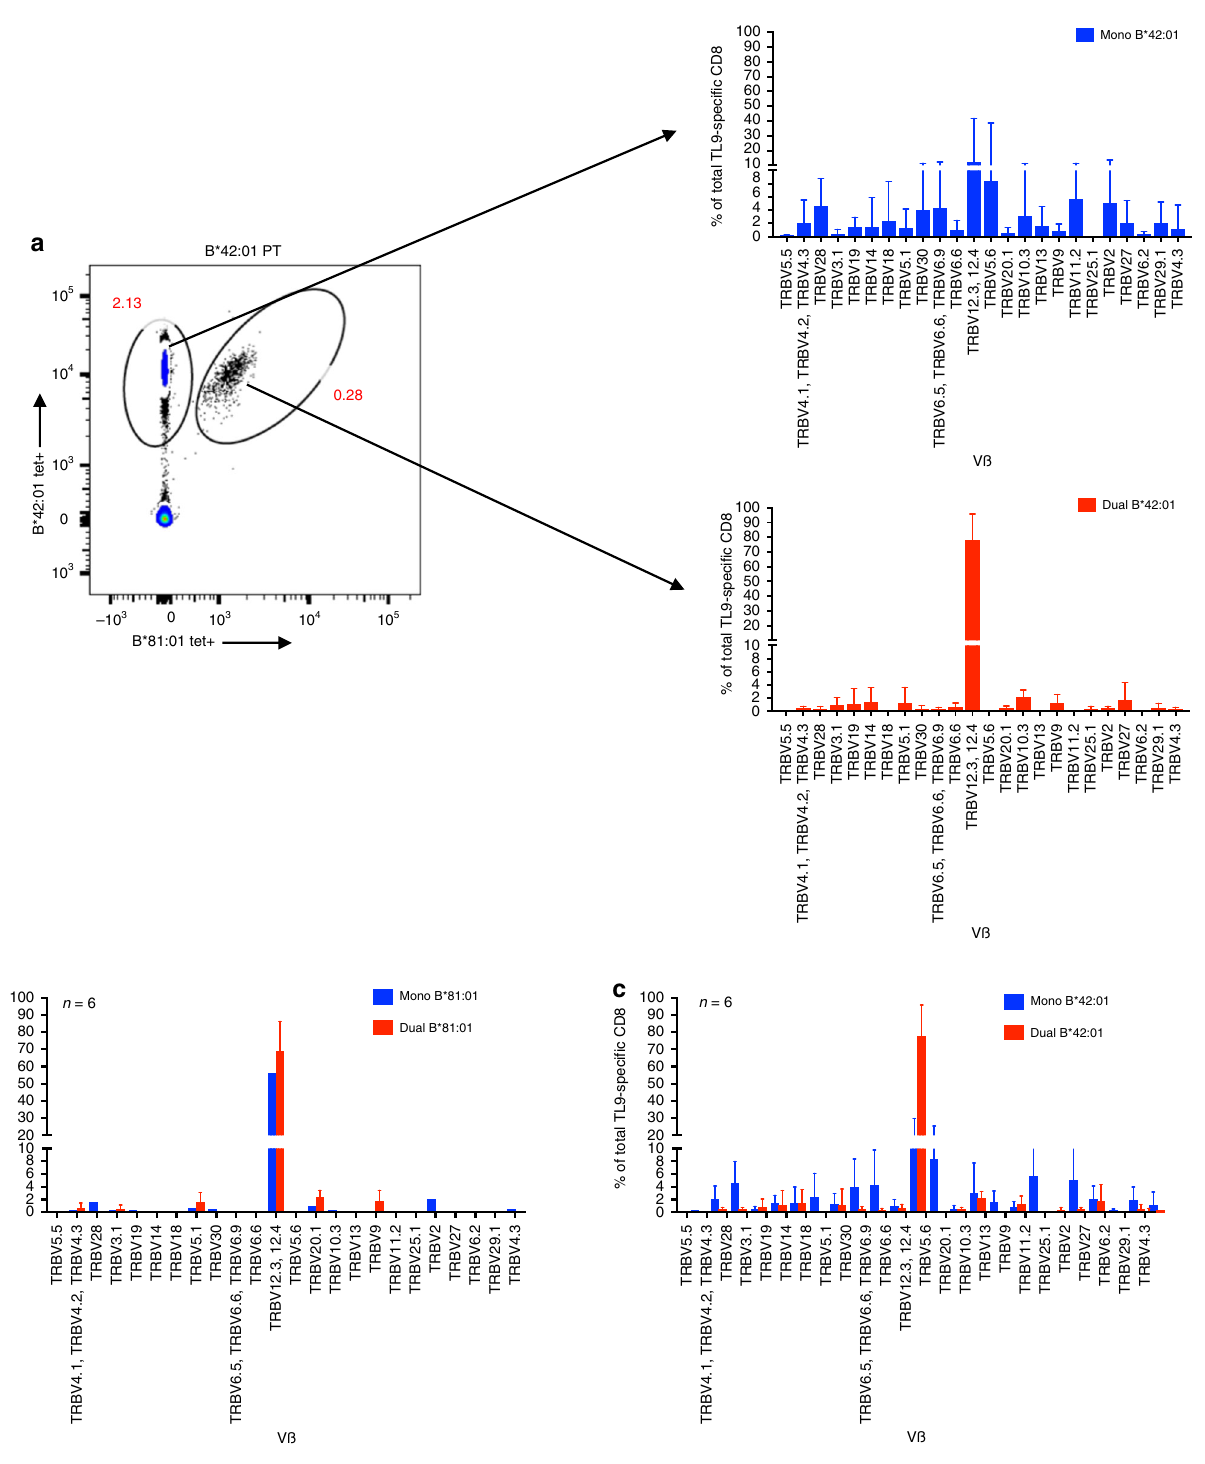
Fig. 2 Enrichment of TCR V β 12 – 3/12-4 in dual-reactive T cells. A representative fl ow plot for one B*42:01 expressing individual displays mono- and dual- TL9 tetramer reactive T cell populations and linked TCR V β expression pro fi les based on antibody staining ( a ). Aggregate results for TCR V β usage are shown for mono- (blue) and dual-reactive (red) T cells from six B*81:01 expressing individuals ( b ) or six B*42:01 expressing individuals ( c